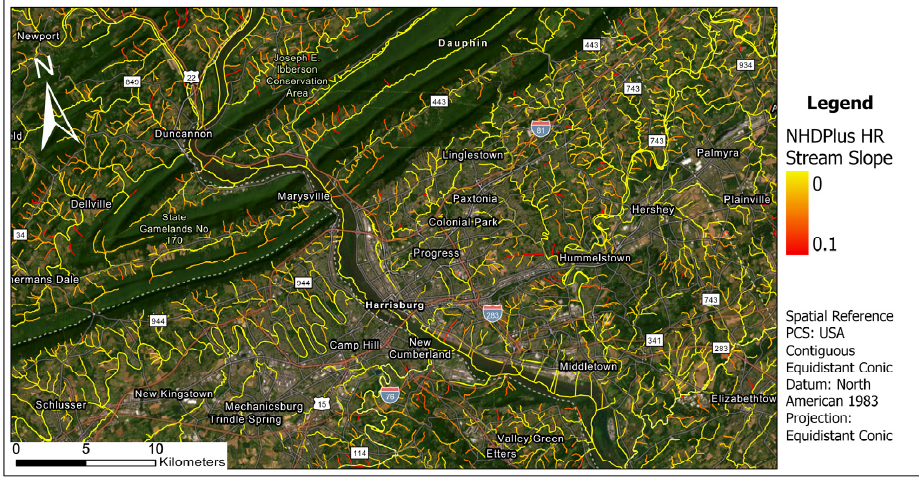
Figure 5. Stream slope map of the area around Harrisburg, Pennsylvania.